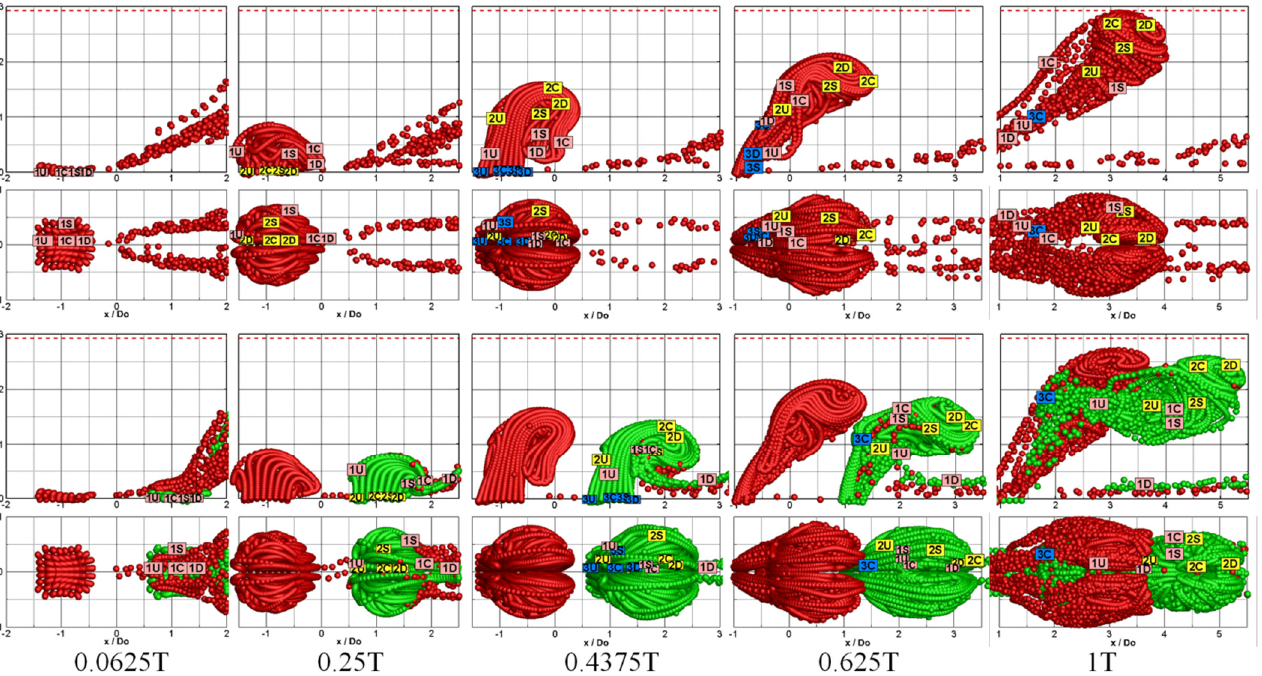
Figure 6. Evolution of fluid particles of the single SJ ( upper two rows) and in-phase twin SJs ( lower two rows). Group 1 particles (in pink) are released at t / T = 0.0625, Group 2 particles (in yellow) are released at t / T = 0.25, and Group 3 particles (in blue) are released at t / T = 0.4375. All particles are released at the actuator orifice exit.